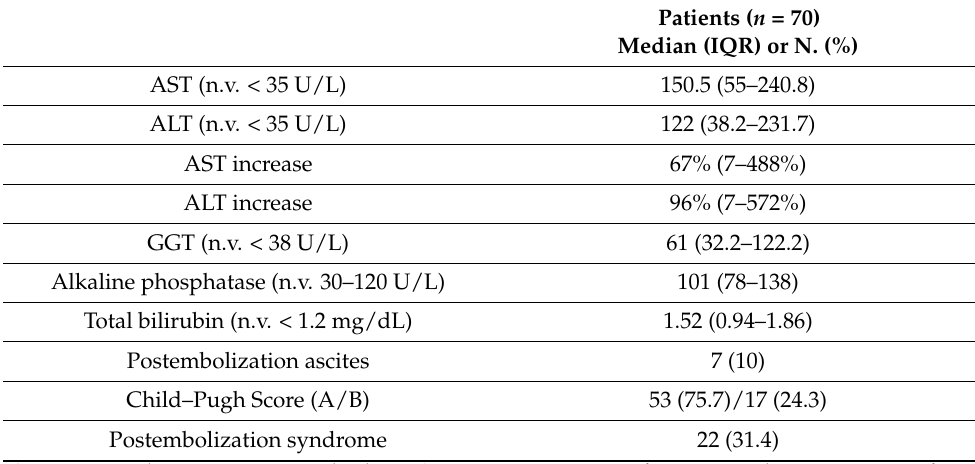
Table 2. Laboratory data after conventional chemoembolization. .